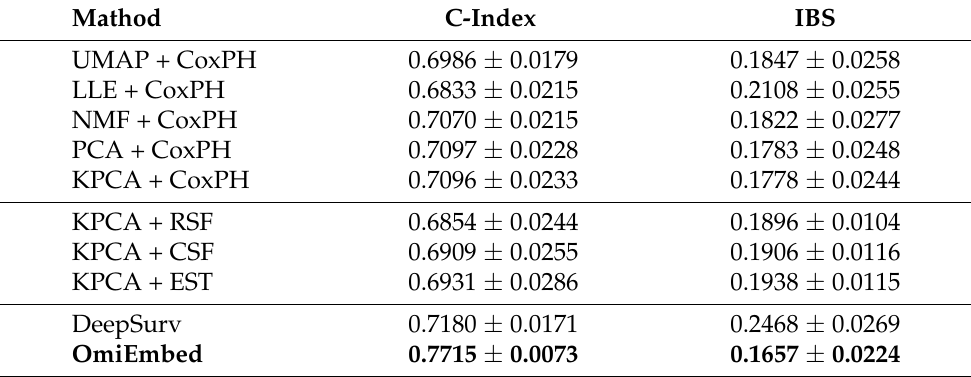
Table 7. The survival prediction performance of OmiEmbed and nine other methods on the GDC dataset. For C-index, higher values mean better prediction performance. For IBS score, lower values mean better prediction